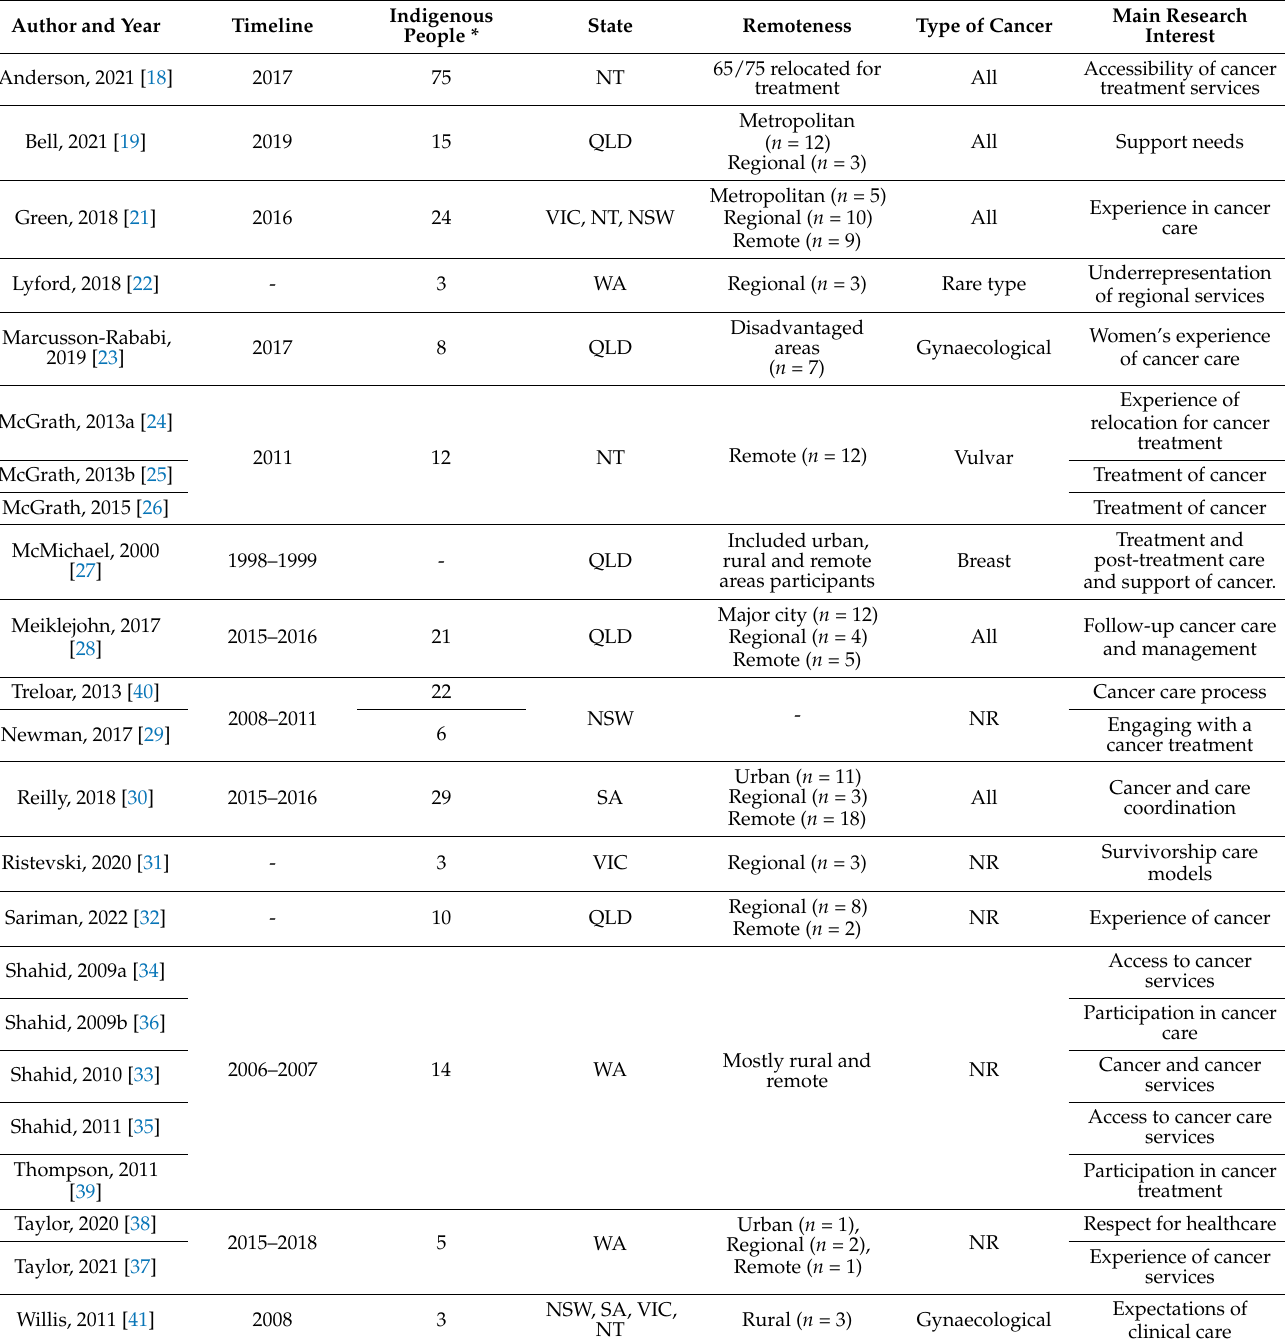
Table 1. Study and patients’